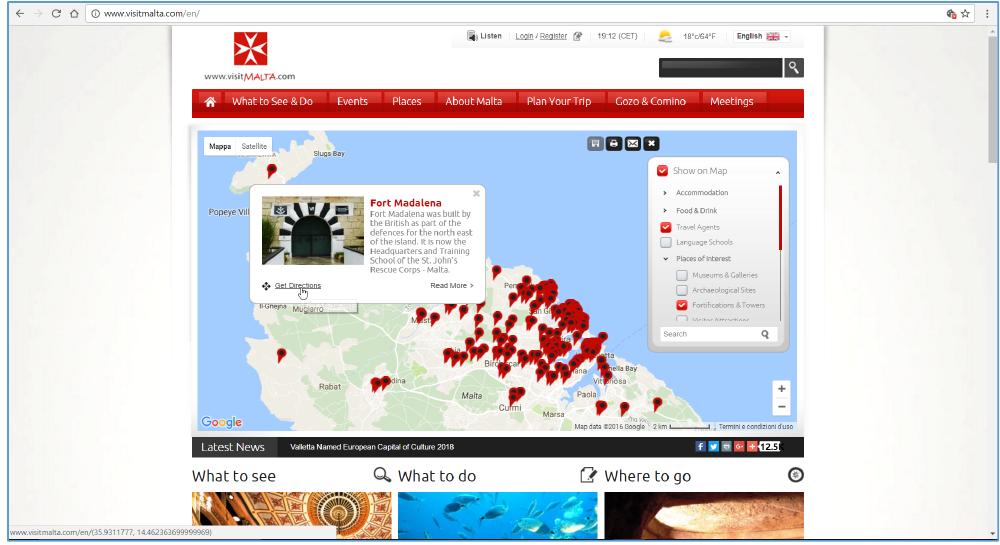
Figure 2. The interactive map of Malta—screenshot of screen session in the website [6].